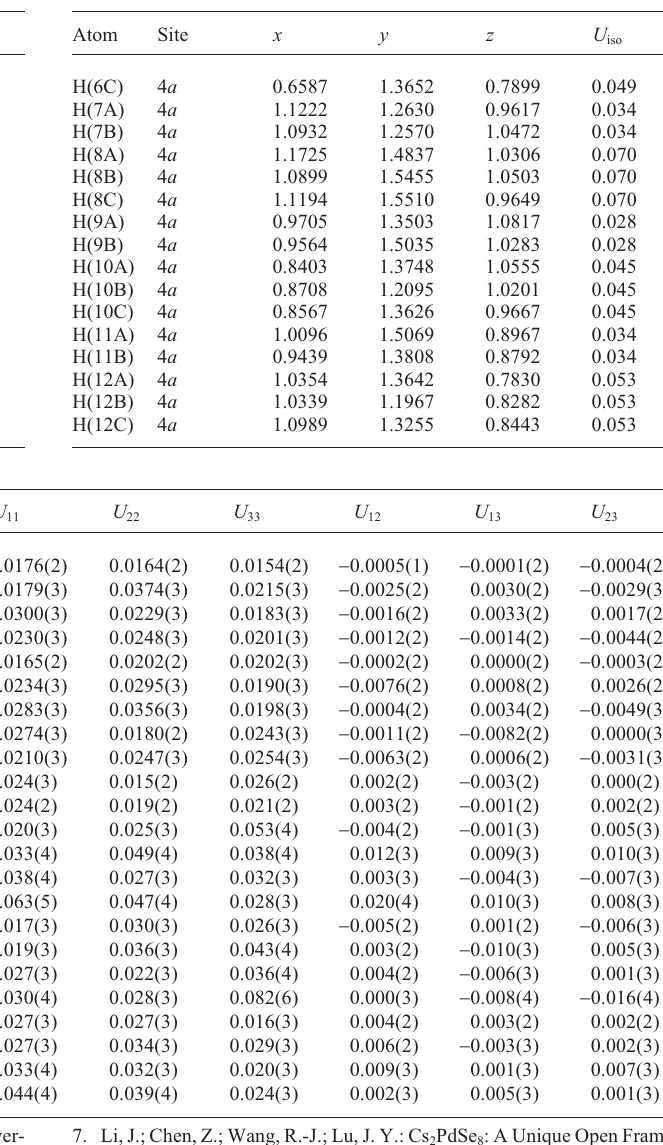
Table 2. Atomic coordinates and displacement parameters (in Å 2 ) .